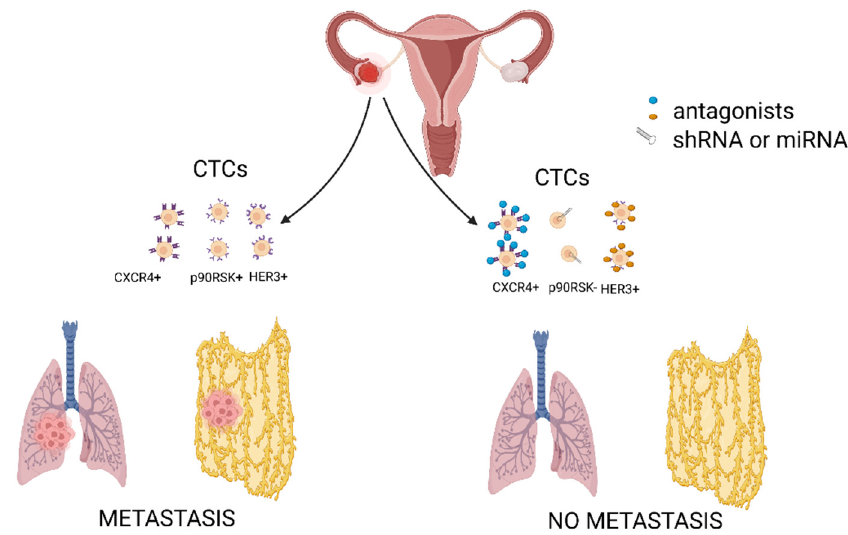
Figure 3. Ovarian CTCs may attach to the omentum or cause metastasis elsewhere. Pro-invasive features of ovarian tumor cells are determined via specific receptors, such as CXCR4 and p90RSK. Blocking of these targets may inhibit ovarian cancer metastasis. Created with https://biorender.com/ (accessed on 31 October 2022).